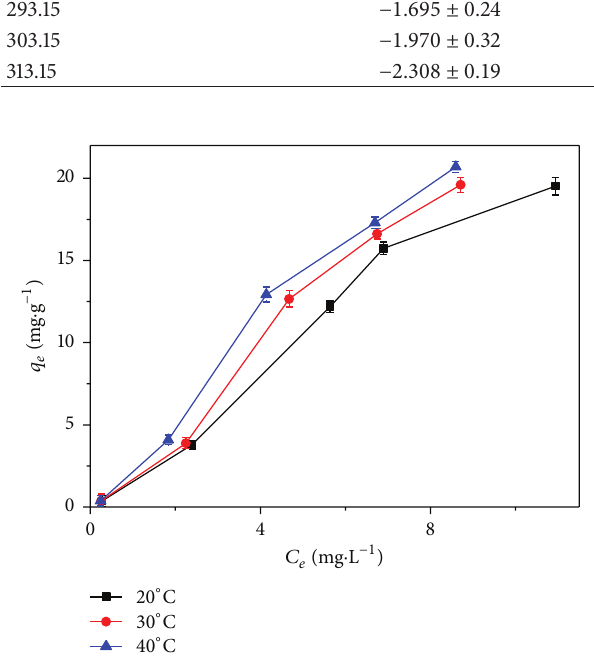
Figure 5: Adsorption isotherm of As (III) on Ce-Al-Fe trimetal oxideadsorbentatdifferenttemperature(pH=7.0,initialconcentra- tion of As (III) = 1, 10, 30, 40, and 50mg ⋅ L −1 , and adsorbent dosage = 0.2 g ⋅ L −1